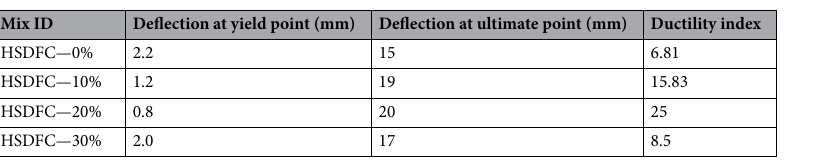
Table 7. Ductility